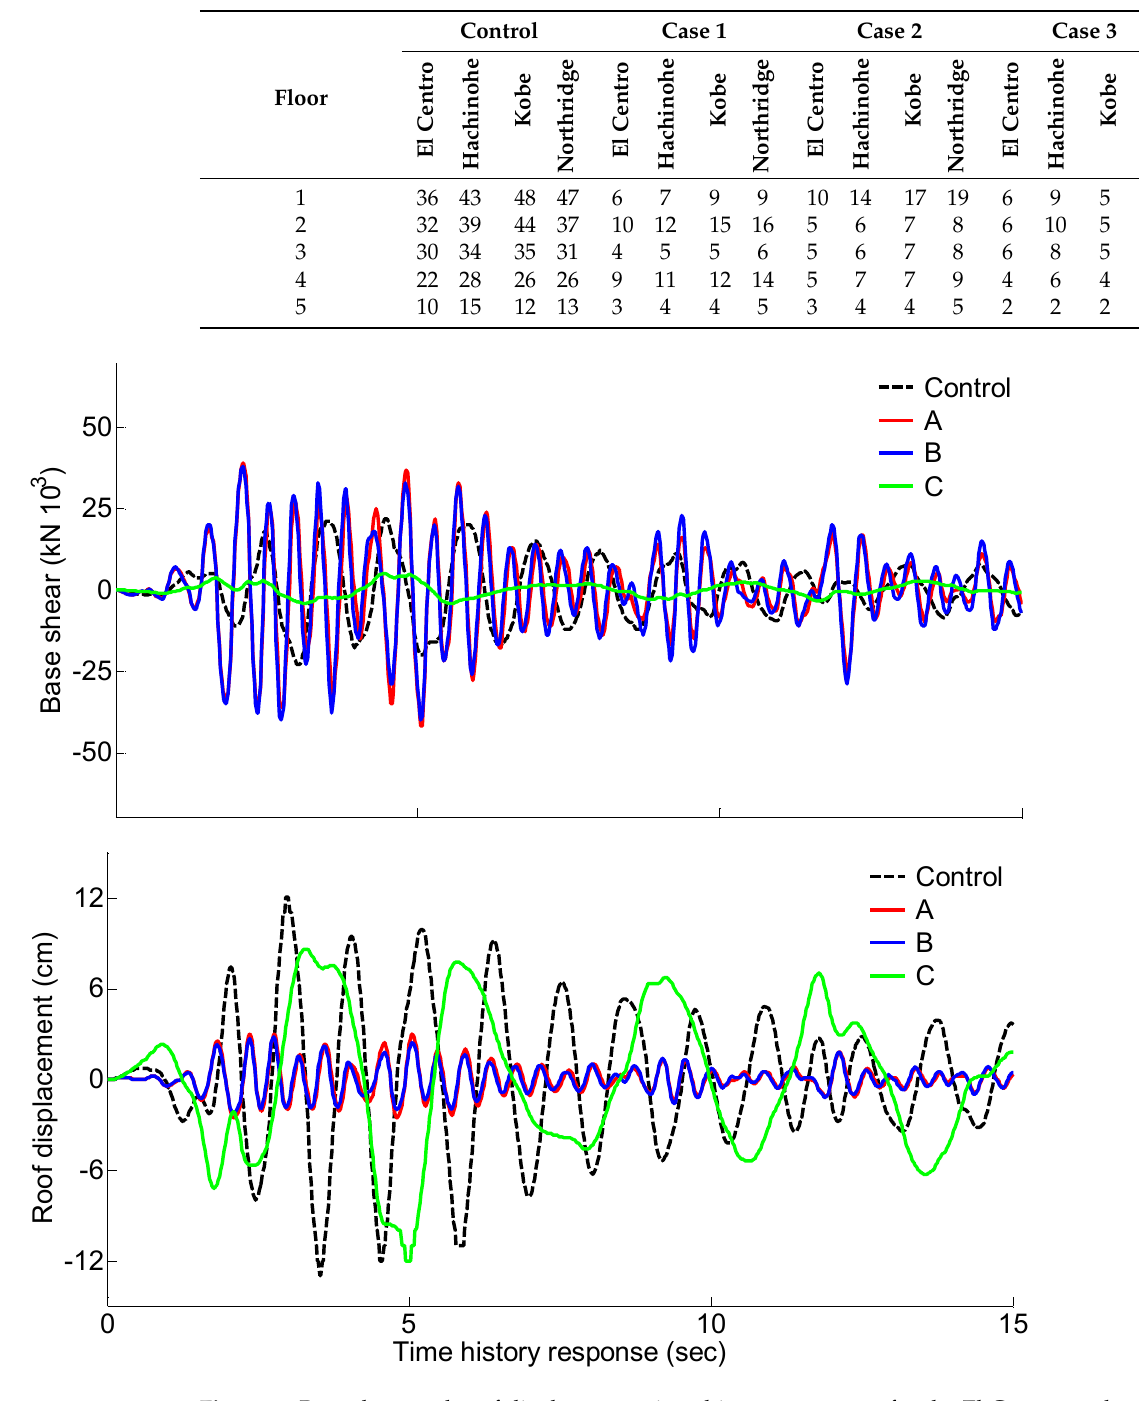
Figure 7. Base shear and roof displacement time–history responses for the El Centro earthquake: (A) Case 1, (B) Case 2, and (C) Case 3. Table 8 details the seismic performance assessment results by means of 𝐽 1 and 𝐽2 . Table 8. Seismic performance evaluation by means of J 1 and J 2.